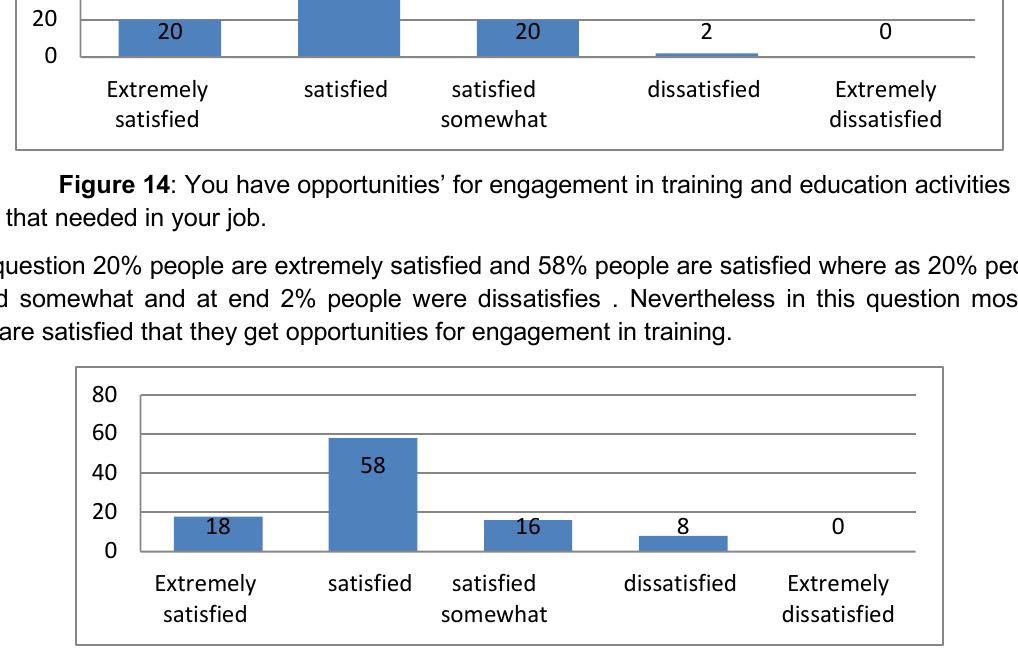
Figure 15: You can receive the financial support from your employer for future